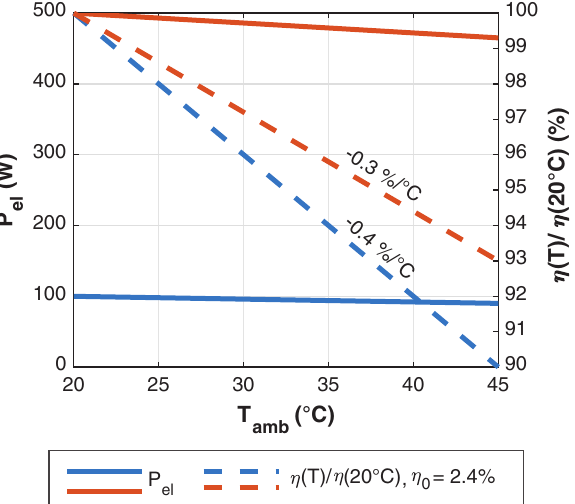
Figure 2. Effect of ambient temperature on the performance of two TEGs models of different nominal power (continuous and dashed